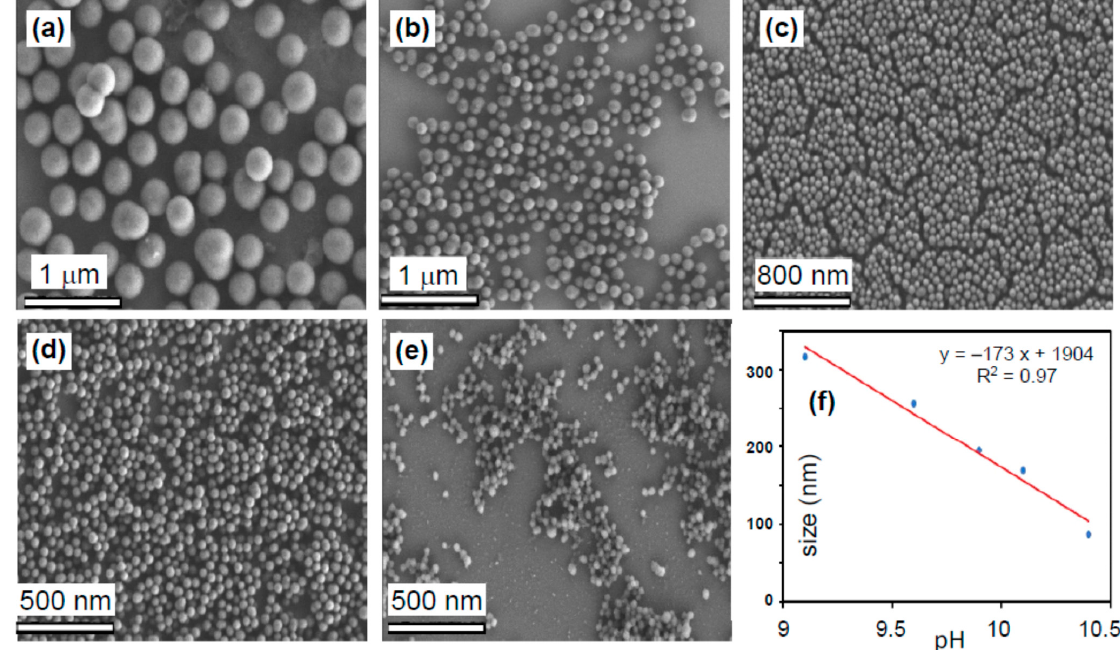
Figure 1. SEM images of mNPs in different volumes of NH 4 OH: ( a ) 0.5 ( b ) 1.0, ( c ) 1.5, ( d ) 2.0, and ( e ) 2.5 mL. ( f ) Plot of mNP diameter vs. pH of NH 4 OH solution.